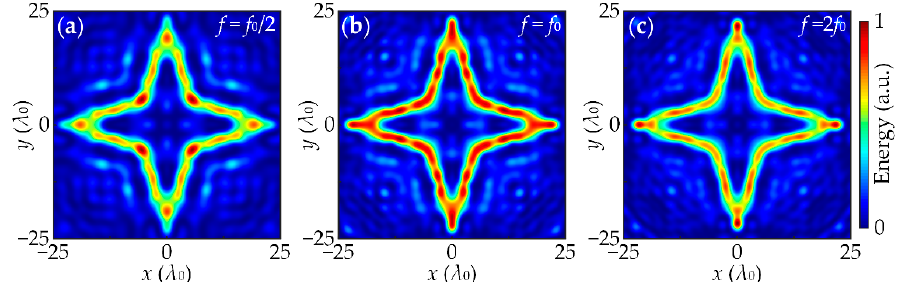
Figure 8. Holographic images of 0.1𝜆 (cid:2868) -thick steel plate with holes. ( a – c ) The normalized sound en- ergy distributions in the image planes of the hologram fabricated with 0.1𝜆 (cid:2868) -thick steel plate with holes are calculated using numerical simulation when the incident frequencies are 𝑓 (cid:2868) 2⁄ , 𝑓 (cid:2868) , and 2𝑓 (cid:2868) ,